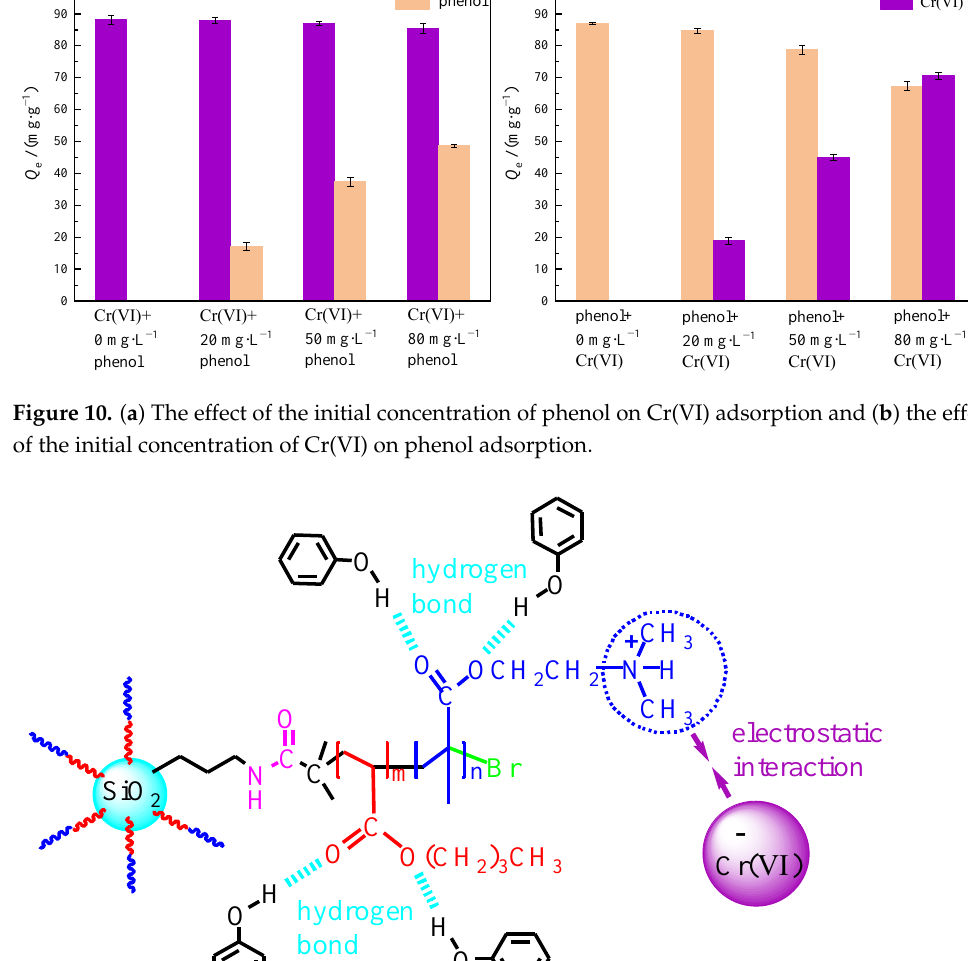
Table 4. Comparison of different adsorbent materials.